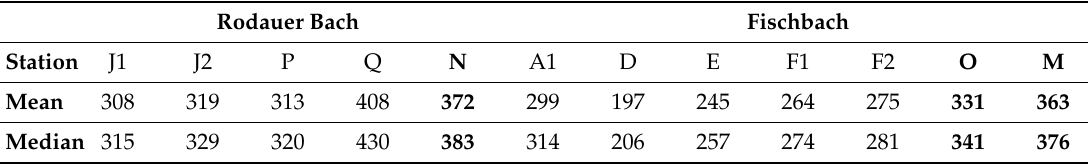
Table 2. Mean and median EC value at each monitoring point using weekly data (June 2017 to October 2019). N and O highlighted in bold as measurement points before confluence of the Rodauer Bach and Fischbach. M highlighted in bold as the catchment